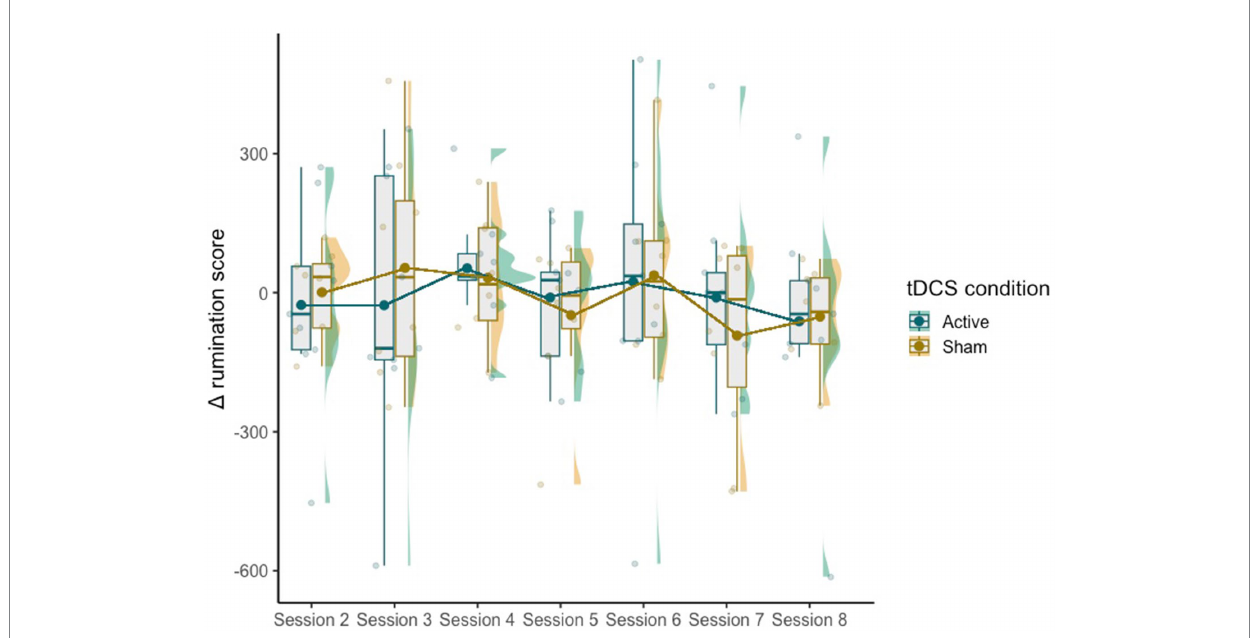
FIGURE 2 The distribution of the difference in post-CBT and pre-tDCS rumination scores.